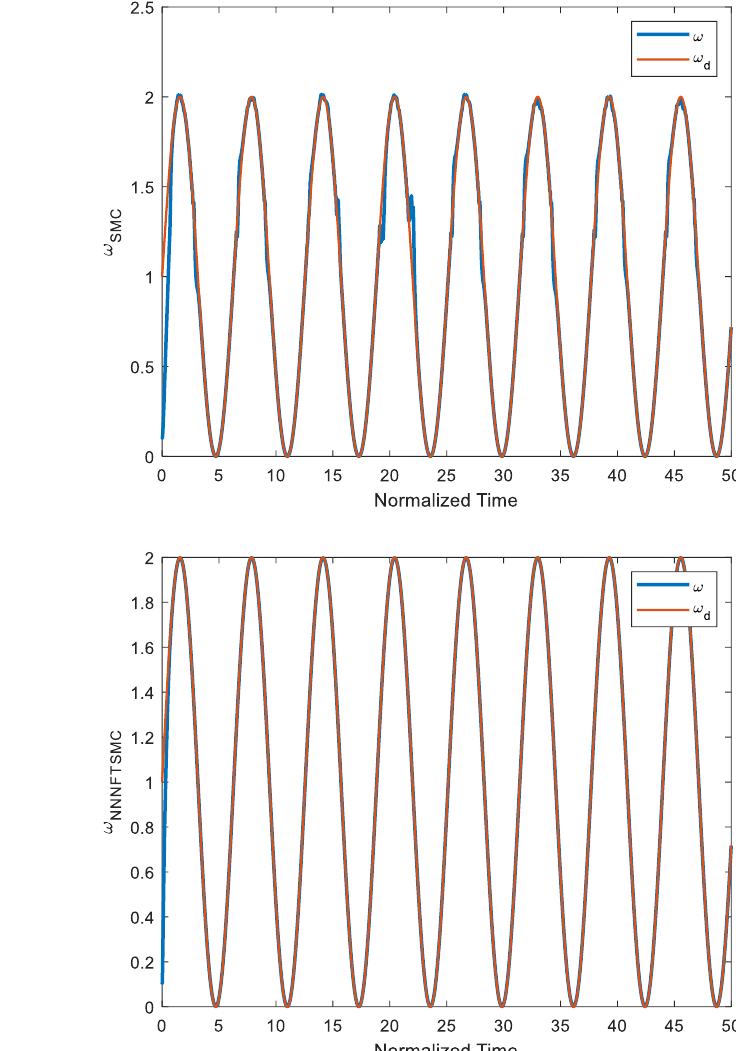
Figure 8. Periodic response of HTGS using ( a ) SMC and ( b ) proposed controller.